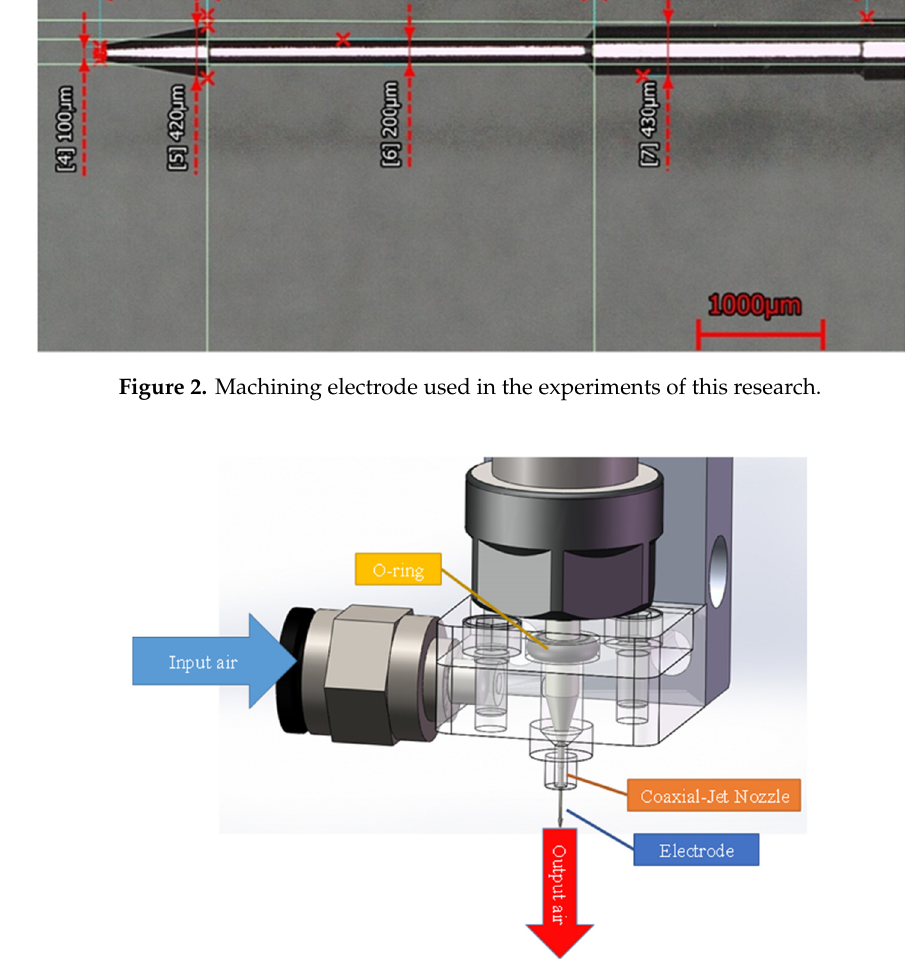
Figure 3. The isometric view of the self-developed and designed coaxial-jet nozzle.